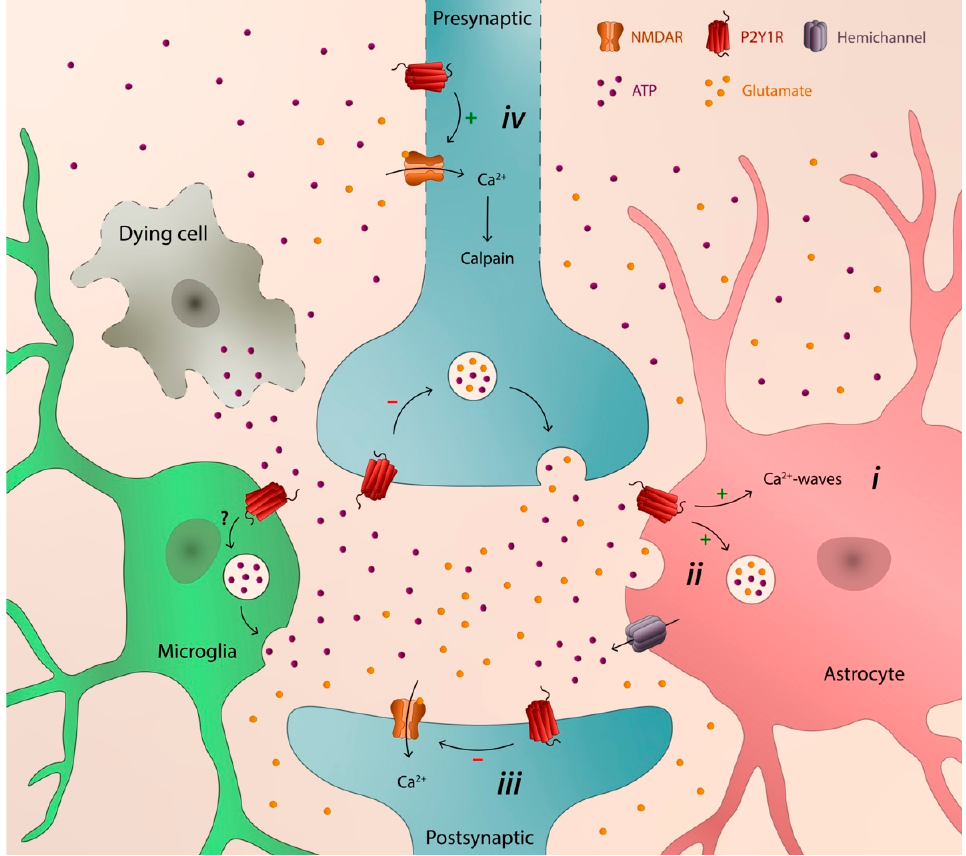
Figure 1. Schematic illustration depicting the transcellular capability of P2Y1R to catalyze neuro- degeneration: ( i ) astrocytic hyperactivity; ( ii ) release of glutamate from astrocytes; ( iii ) depression of synaptic activity; and ( iv ) early axonal degeneration, synaptic loss, and later neuronal death.